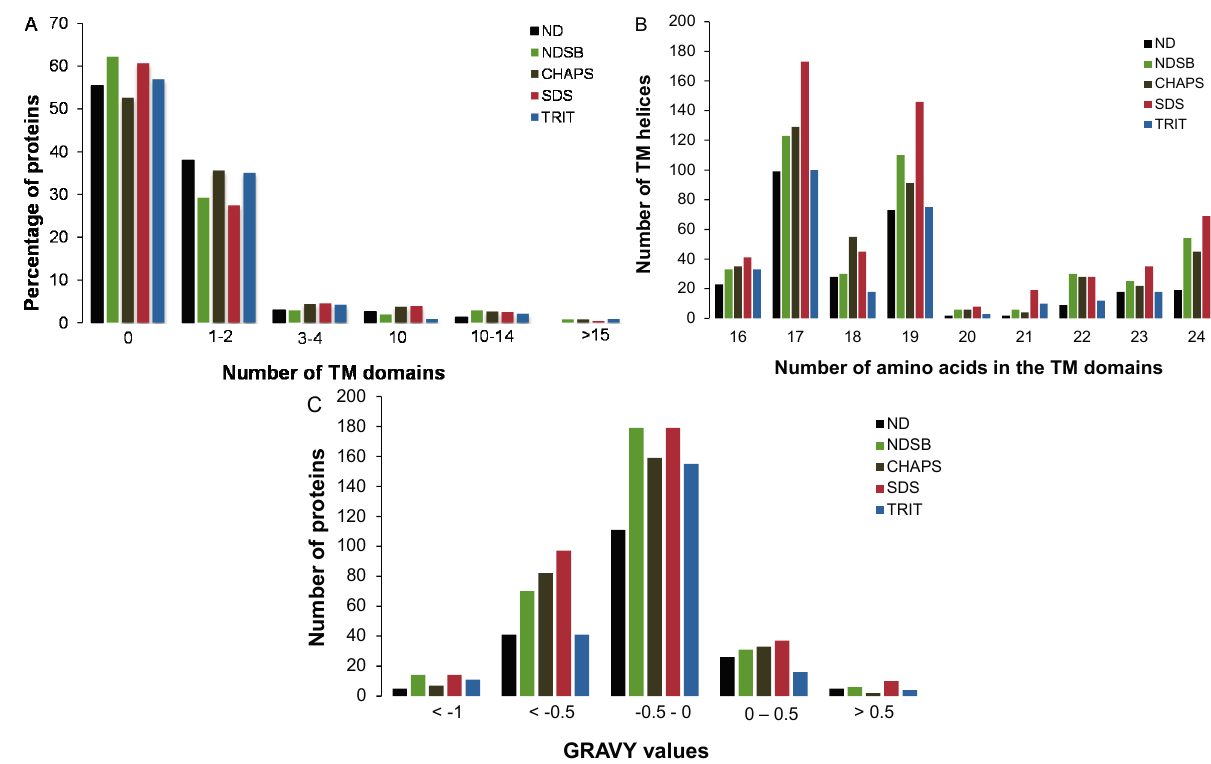
Figure 3. Number of proteins containing ( A ) transmembrane domains, ( B ) number of amino acids per domain and ( C ) grand average of hydropathy (GRAVY)